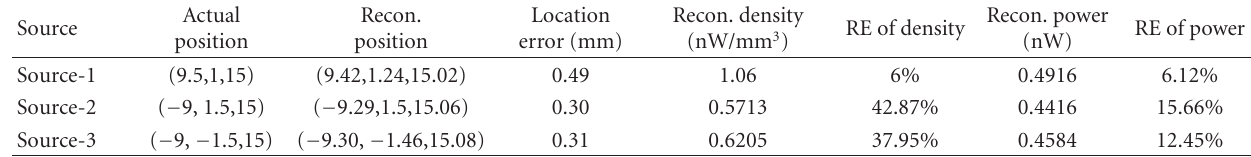
Table 2: Quantitative results and the comparison with the actual sources in multisource case.